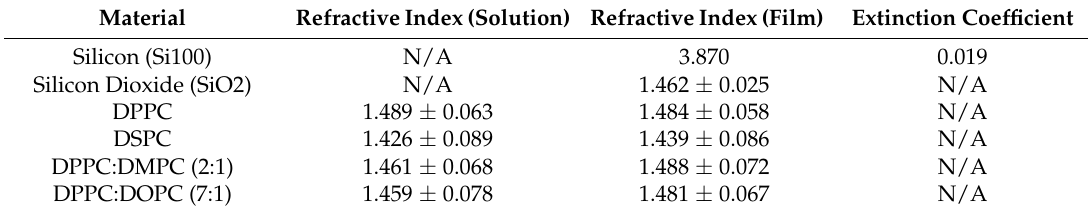
Table 1. Refractive indexes measured by Abbe refractometer in solution and in solid (film) used for ellipsometry model.